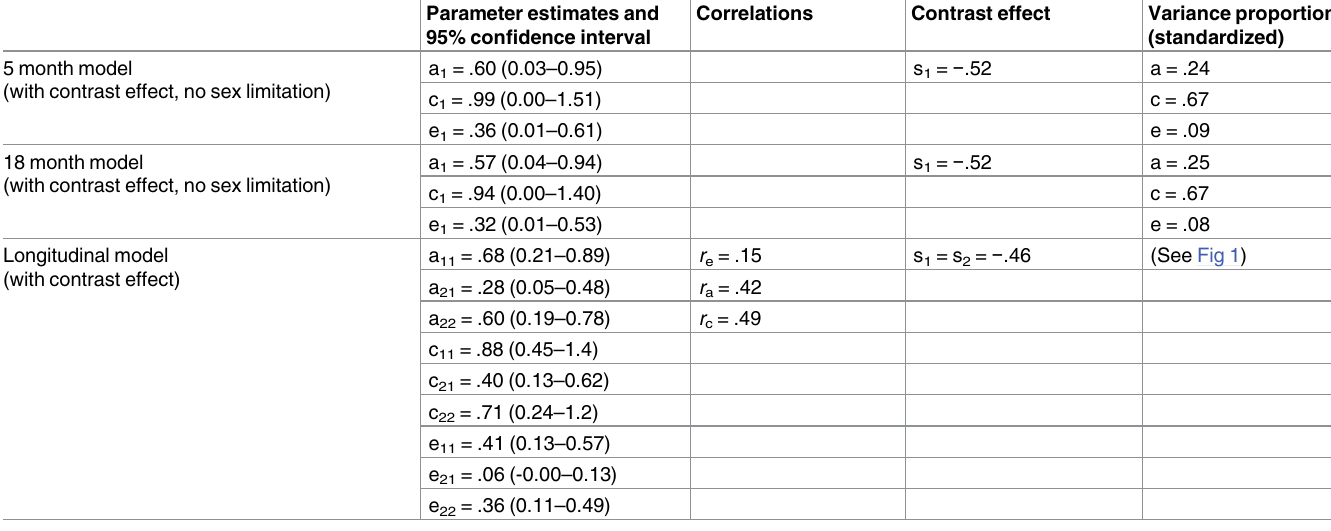
Table 4. Longitudinal standardized parameter estimates,confidence intervals, and